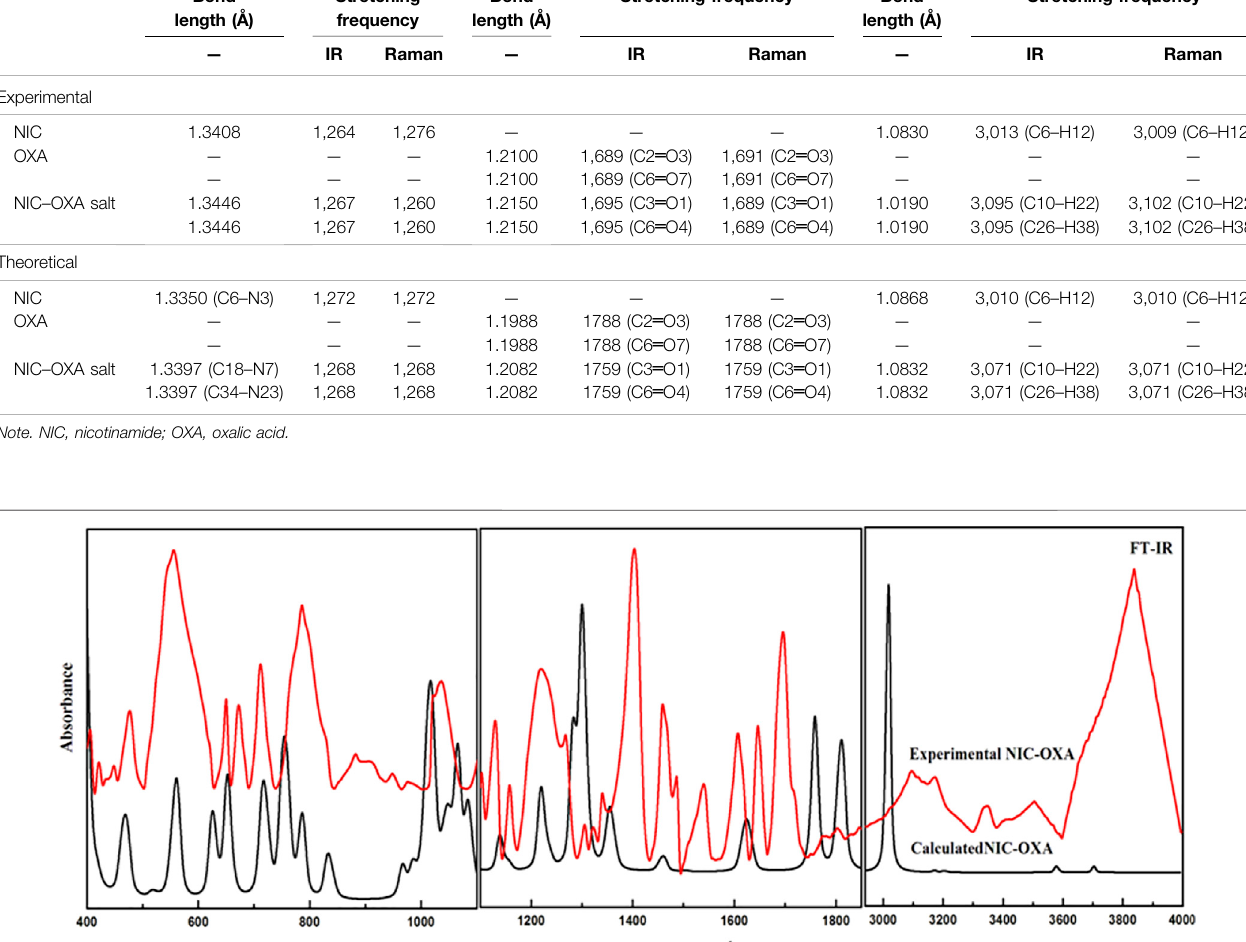
Frontiers in Chemistry |